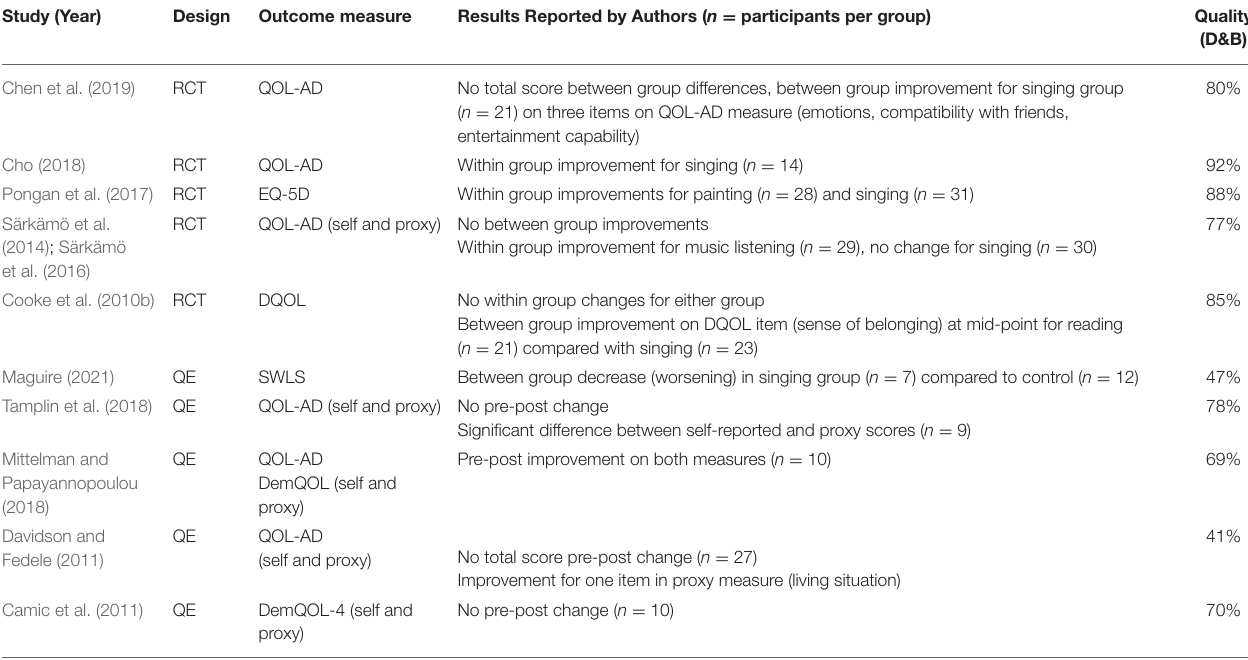
TABLE 3 | Overview of results for quality of life